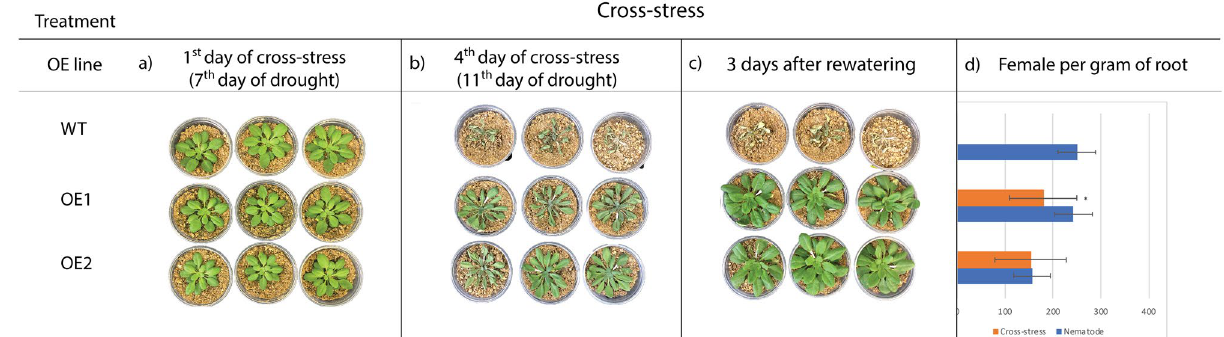
Figure 6. Cross-stress assay in A. thaliana OE1 and 2 lines and WT plants. (a) Plants at the 1st day of cross- stress treatment; (b) plants at the 4th day of cross-stress treatment; (c) plants at the 3rd day after rewatering; (d) female per gram of roots of plants submitted to the cross-stress and individual nematode treatments. Values are mean of 10 individuals and significant differences between nematode and cross-stress plants are marked with an